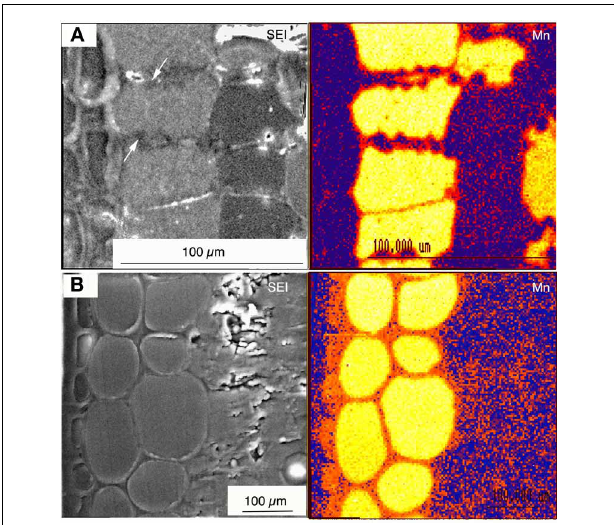
FIGURE 2 | Wet specimen preparation. Figure taken from Fernando et al. (2012). Cryo-fixed frozen hydrated and planed leaf cross sectional surfaces of Virotia neurophylla (A) and Maytenus fournieri (B) lightly surface sublimed and Al-coated. LHS panels show cryo-SEM images (15kV); and RHS panels show corresponding quantitative X-ray maps with localized vacuolar Mn highlighted in orange to yellow (highest).